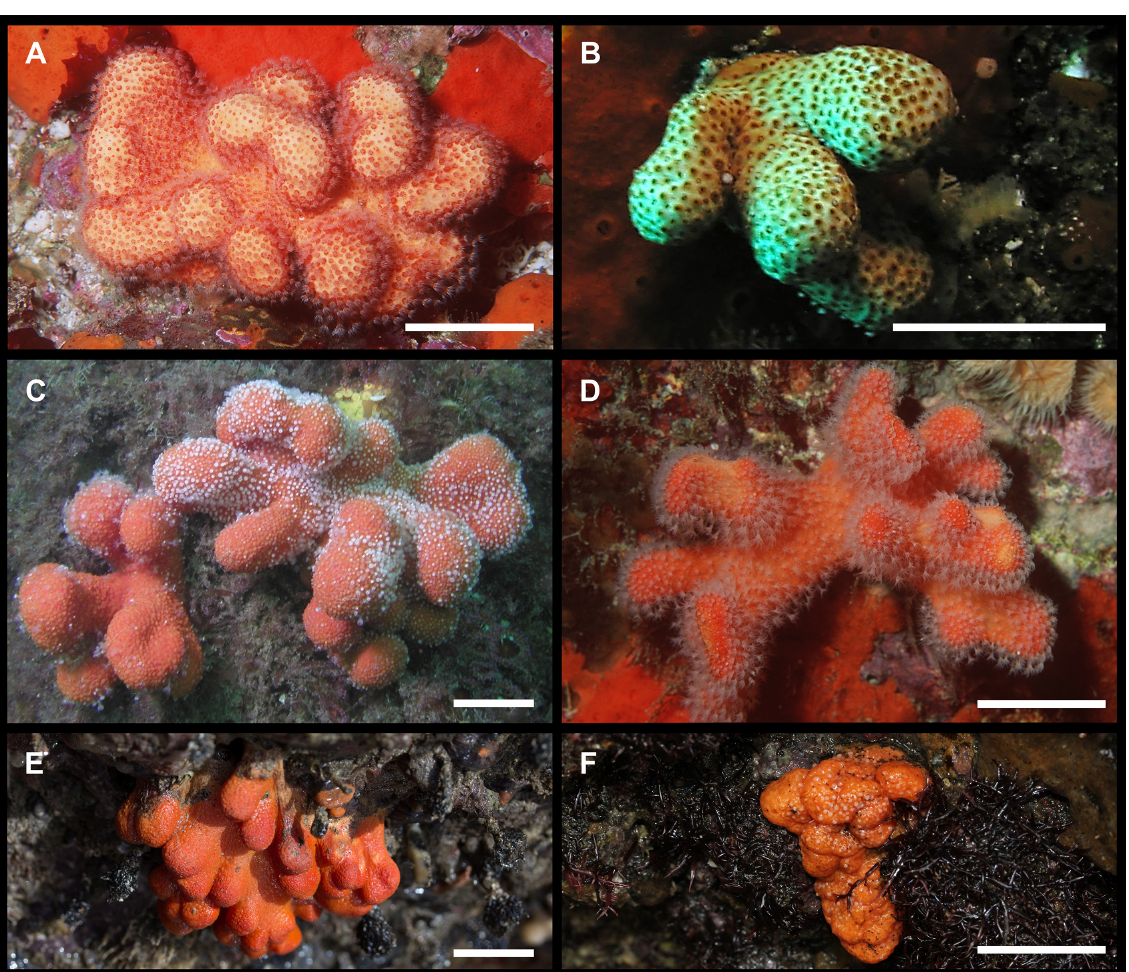
Fig. 4. In situ photographs of species of Kotatea gen. nov. usually possessing robust